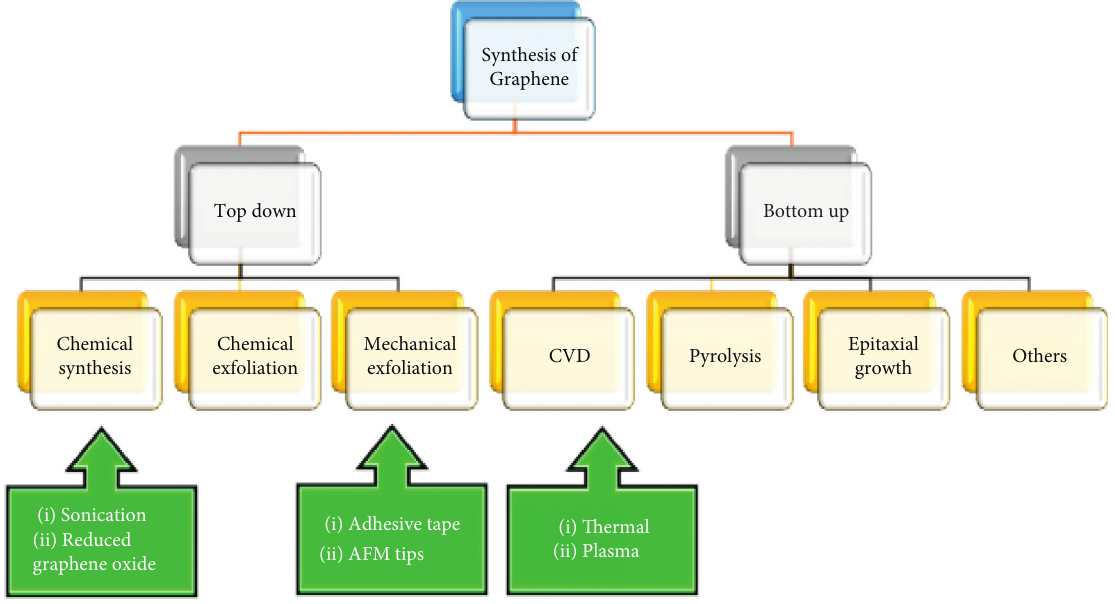
Figure 3: A schematic on various synthetic methods for